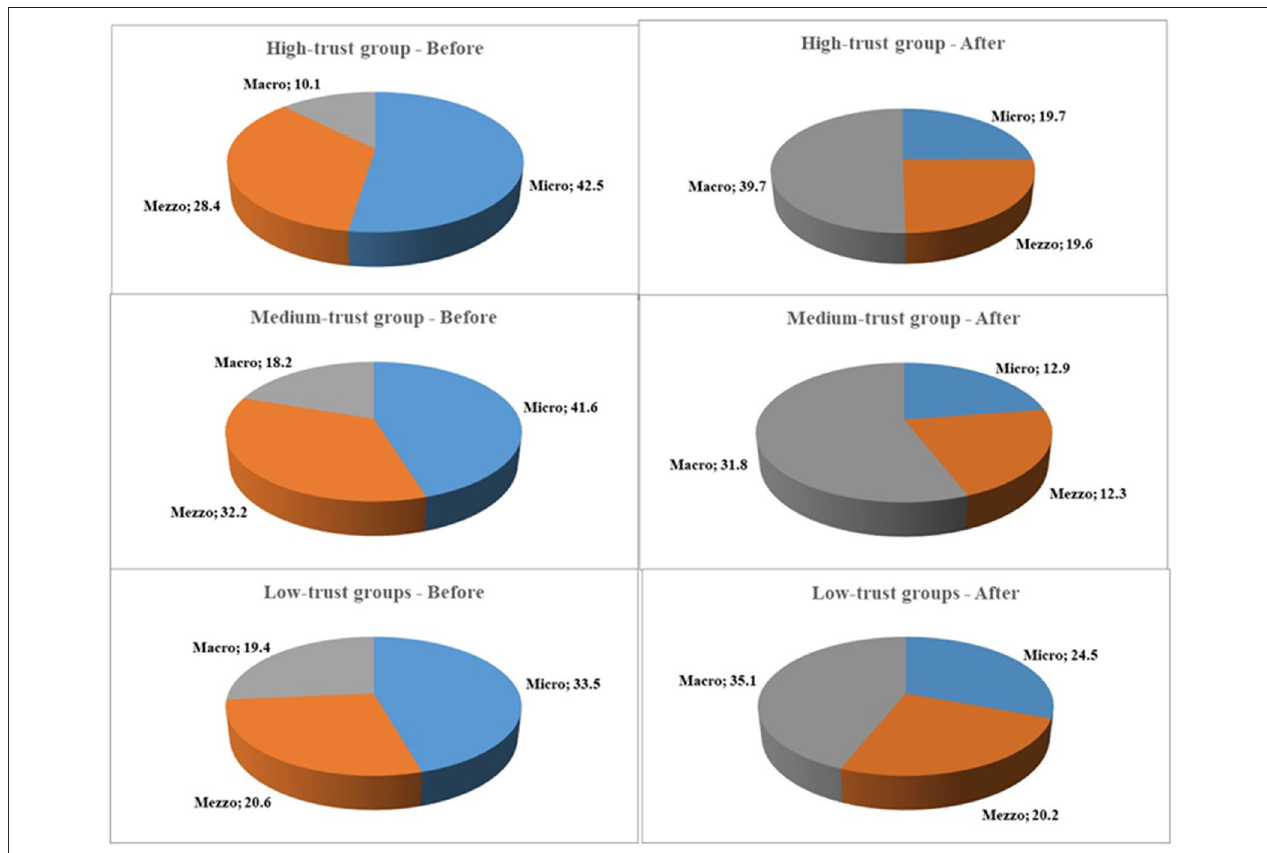
FIGURE 2 | Overview of the relative effect of the three layers, micro, mezzo, and macro, on LS. Results of multilevel analysis. Levels: individual, community and country. Separated by groups of countries stratified by overall trust and as before and after financial crisis 2008/2009. N =